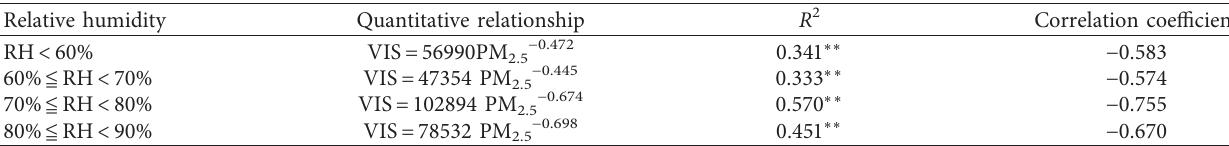
Figure 7: Relationship between atmospheric visibility and PM 2.5 concentration under different relative humidity conditions. Table 2: Quantitative relationships between visibility and PM 2.5 concentration under different relative humidity conditions. Note: ∗∗ indicates that the significance level of a � 0.01 has been passed.